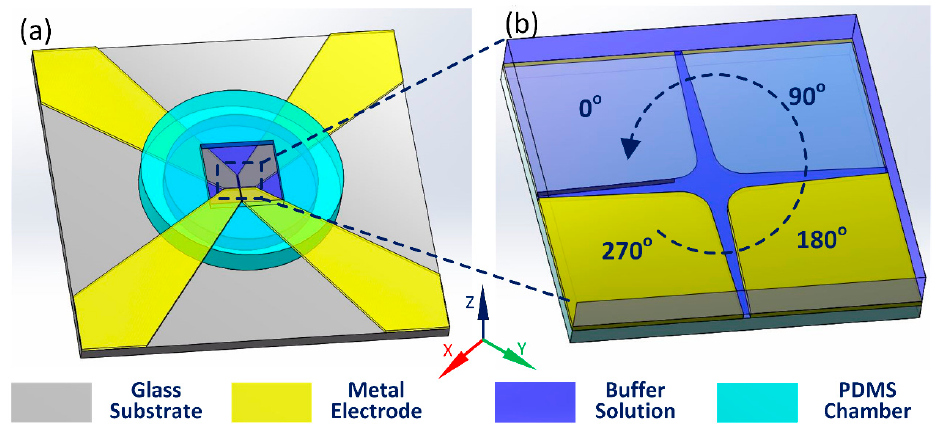
Figure 3. Construction of the 3-D simulation model: ( a ) Schematic of the 3-D computational domain; ( b ) A top view of the four-phase polynomial electrode configuration.